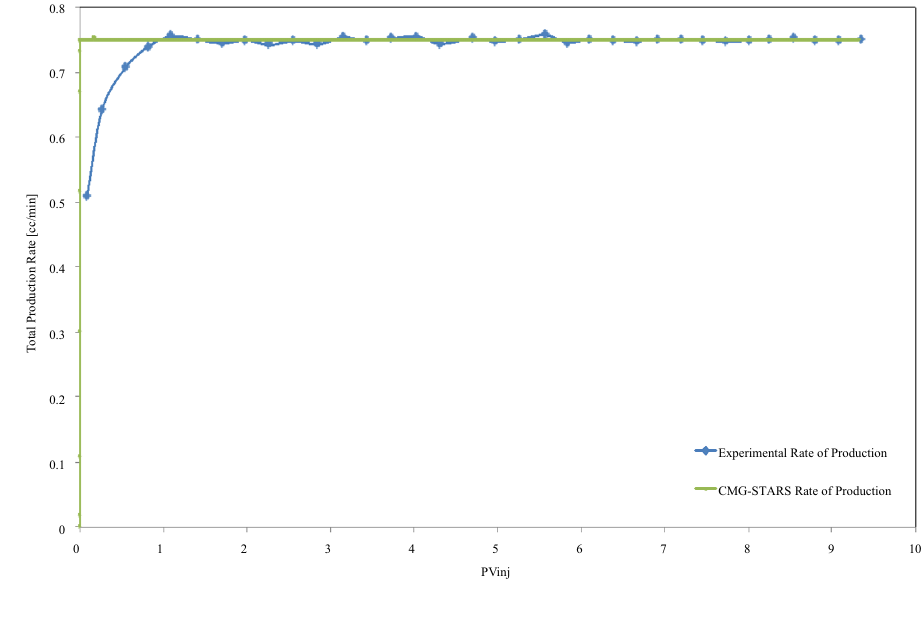
Fig. 9 History matching of the experimental and simulation total production rates for pure SPB